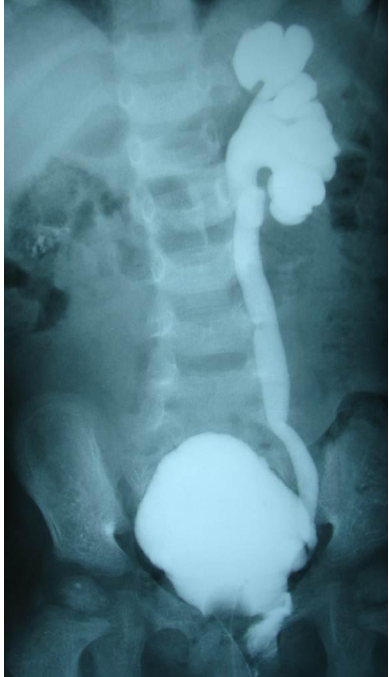
Figure 3: MCUG showing